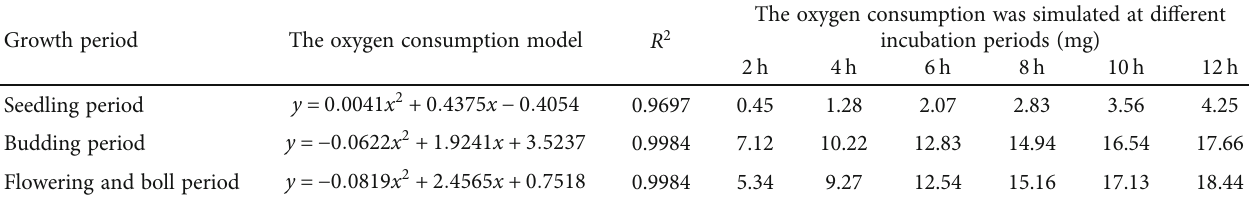
Table 1: Simulation table of oxygen consumption per cotton plant.